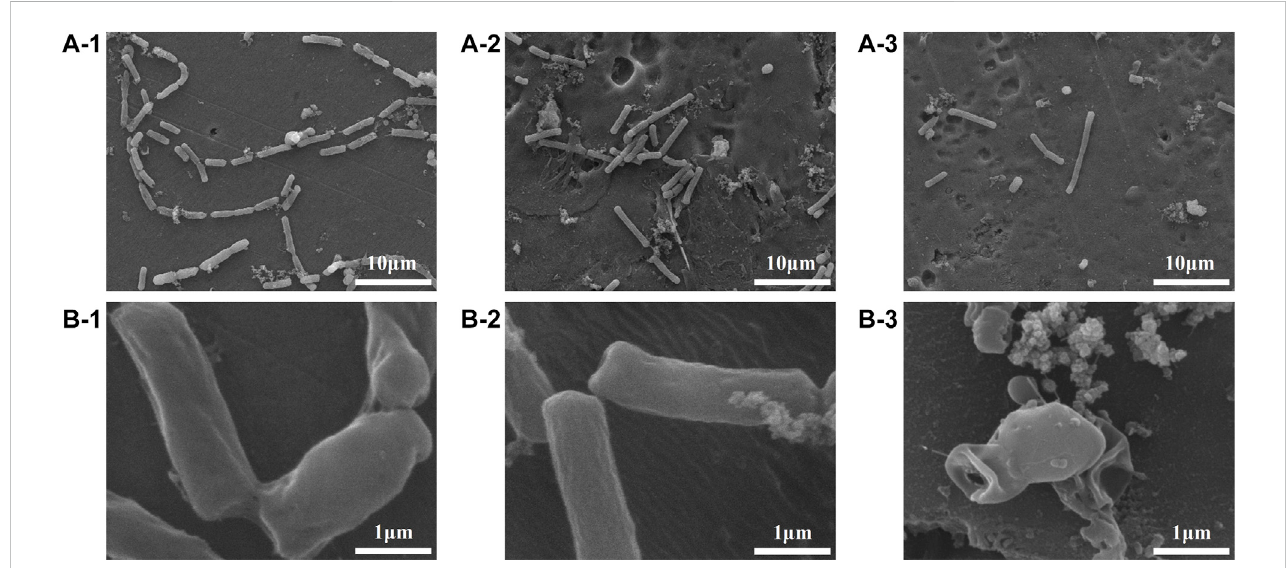
FIGURE 7 FESEM images showing the adhesion behaviours of Bacillus sp . on the Al specimens (1), Al-COOH specimens (2), and Al-peptide specimens (3) with ×2000 (A) and ×20,000 magni fi cation (B) .